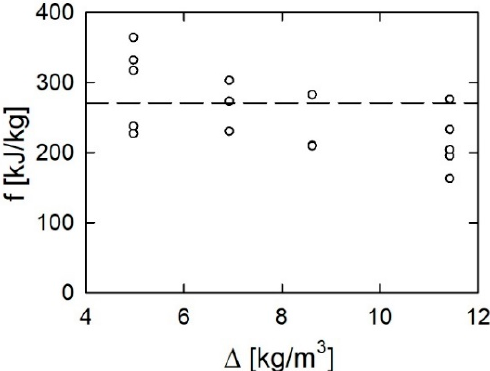
Figure 6. Estimated values of the force (the dashed line is the mean value) (approach 1).